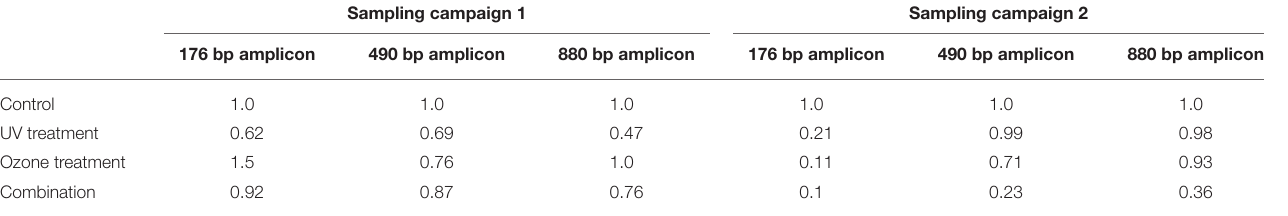
TABLE 3 | Detection of DNA damages via PCR